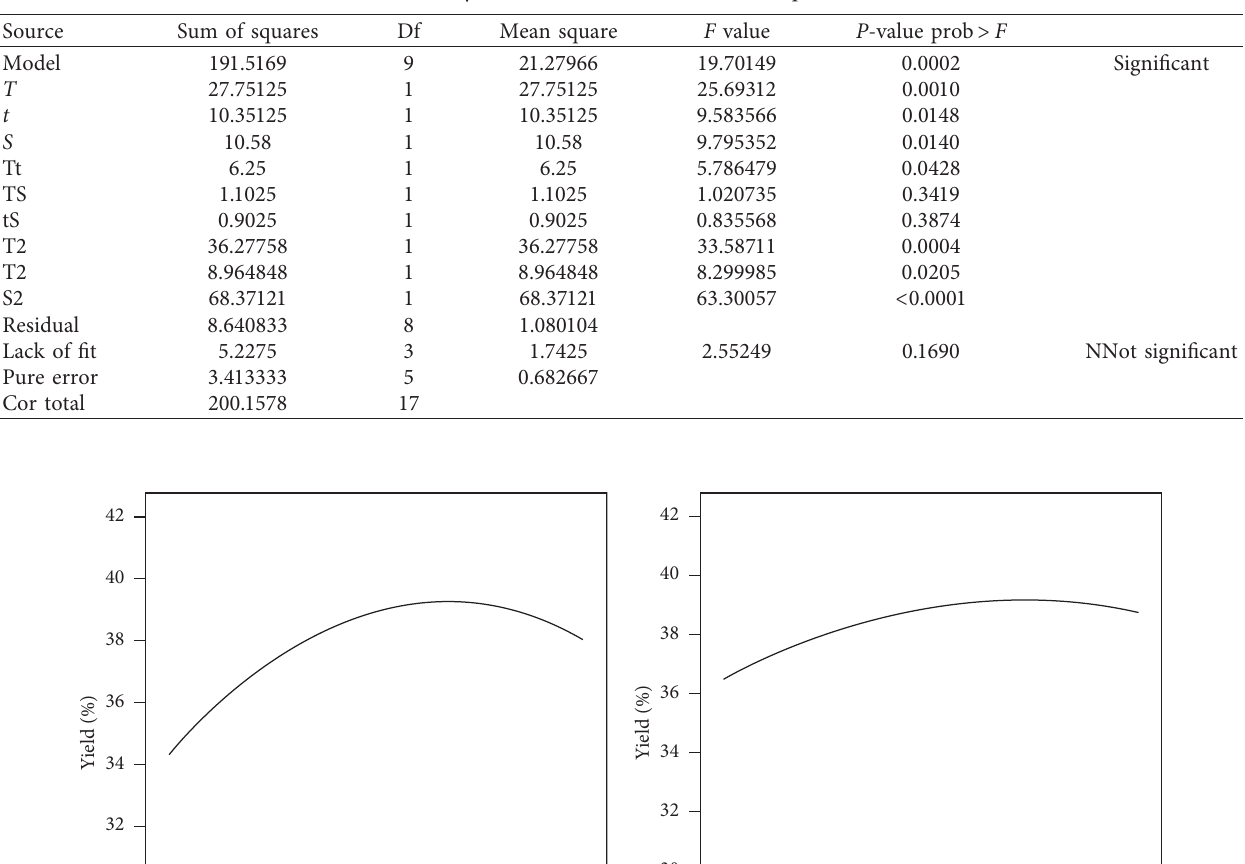
Table 4: The analysis of variance (ANOVA) for the quadratic model.